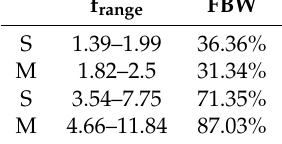
Table 3. Simulated (S) and Measured (M) Fractional Bandwidth Comparison. FBW: Fractional Bandwidth.